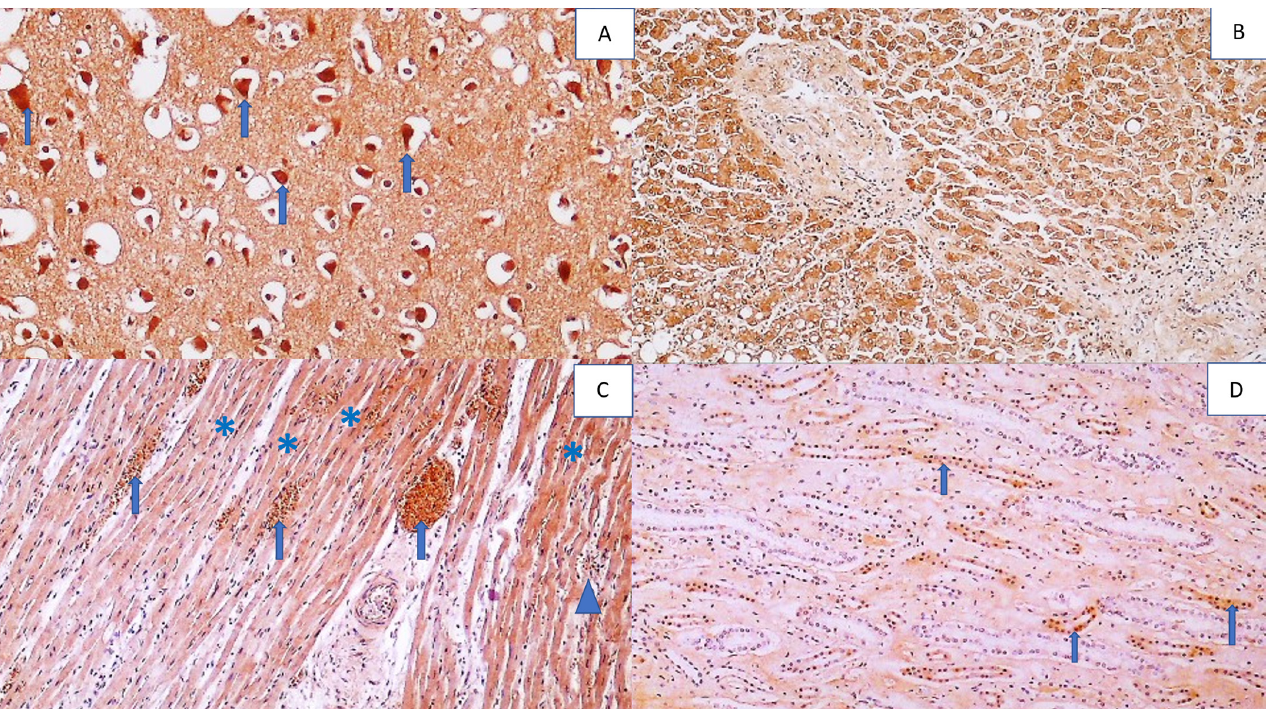
Figure 8. Immunohistochemical positivity for the 4-HNE protein adducts in the vital organs (except the lungs, presented by other figures) of the deceased COVID-19 patient. Photo ( A ) shows very strong immunohistochemical positivity for 4-HNE in neurons (arrows) within the edematous brain tissue (DAB, 400×). Photo ( B ) shows a pronounced intensity (but weaker than that in neurons) of 4-HNE positivity in liver cells (DAB, 200×). Photo ( C ) shows moderate to strong 4-HNE positivity in myocardial muscle fibers affected by myocarditis (asterisks), with strong 4-HNE positivity in myocardial vasculature (arrows) and some inflammatory cells (arrowhead), (DAB, 200 × ). Photo ( D ) shows the weakest intensity of 4-HNE immunopositivity in the epithelium of the renal tubules (arrows) (DAB, 200 ×